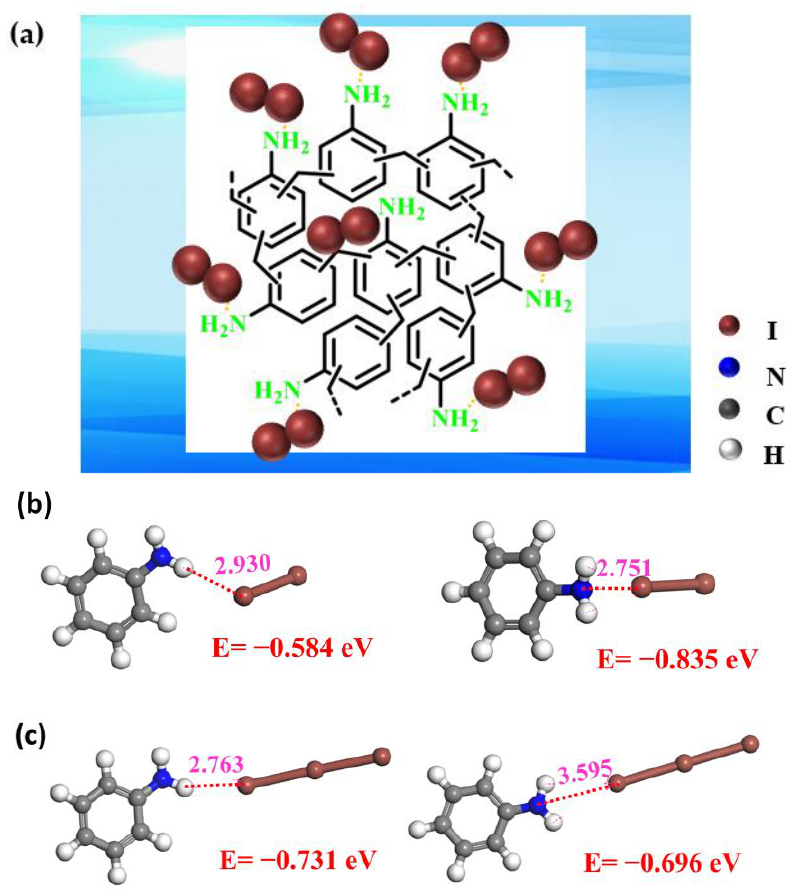
Figure 6. ( a ) Schematic illustration of the iodine uptake mechanisms of AHCPs. Optimized structure of ( b ) aniline unit/I 2 ( c ) and aniline unit/I 3− obtained by DMol3 method.